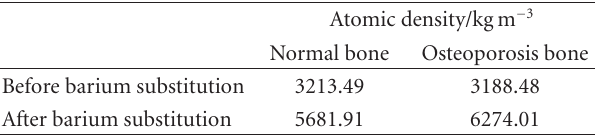
Table 7: Atomic density in hydroxyapatite of osteoporosis and normal bone.